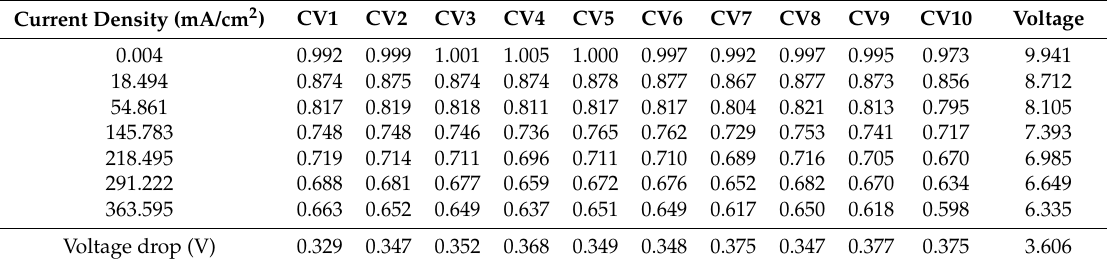
Table 4. Dynamic performance at different relative humidity (70%).